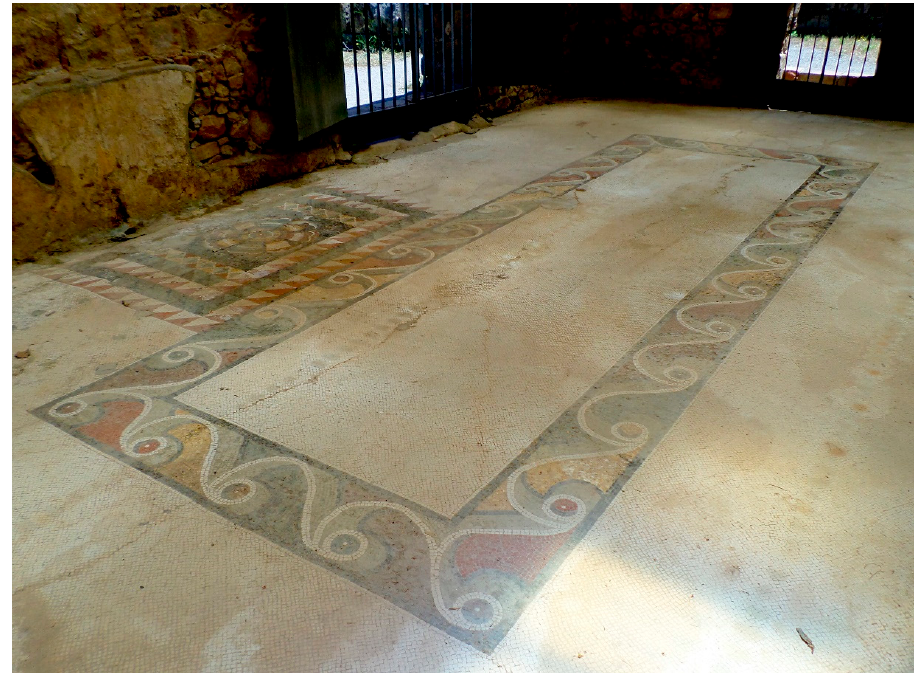
Figure 13. Tyndaris, House B, Hellenistic-era mosaic of room seven (photo by the